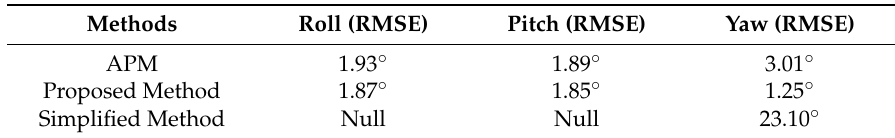
Figure 9. The attitude estimation error. ( a ) Roll error, ( b ) Pitch error, ( c ) Yaw error. Table 2. Flight test error statistics.